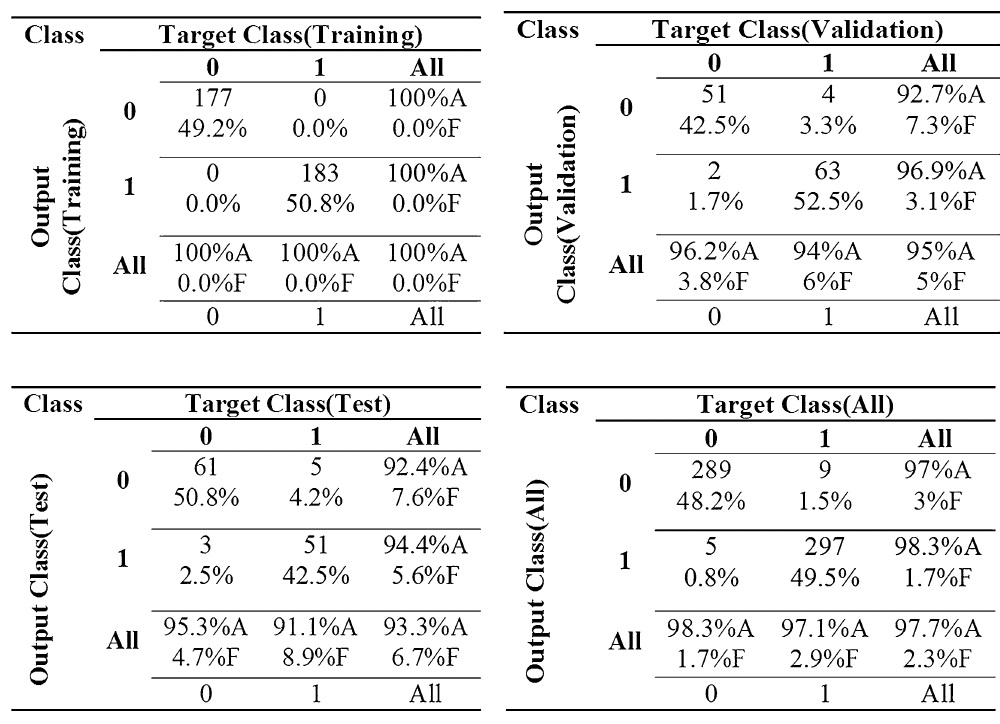
Figure 2. The confusion matrix of MLP neural